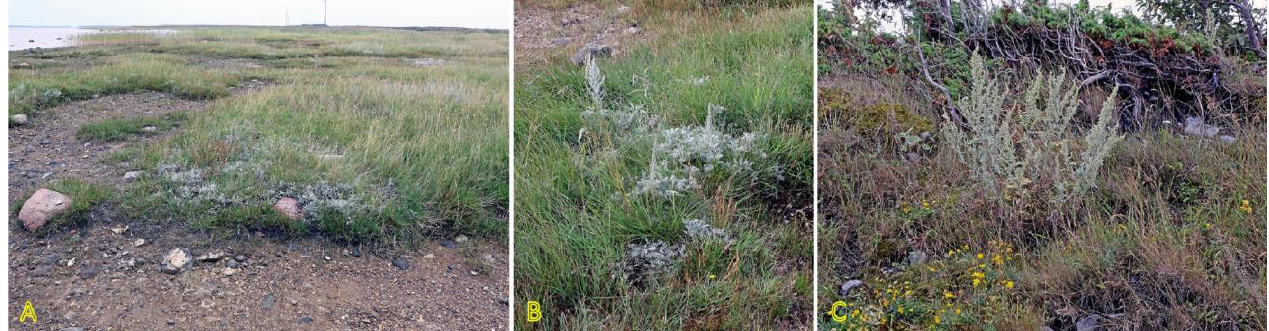
Figure 21. Artemisia maritima plants on a gravel beach on the island of Saaremaa, Estonia ( A , B ). Artemisia absinthium on a beach on the island of Saaremaa, Estonia ( C ).